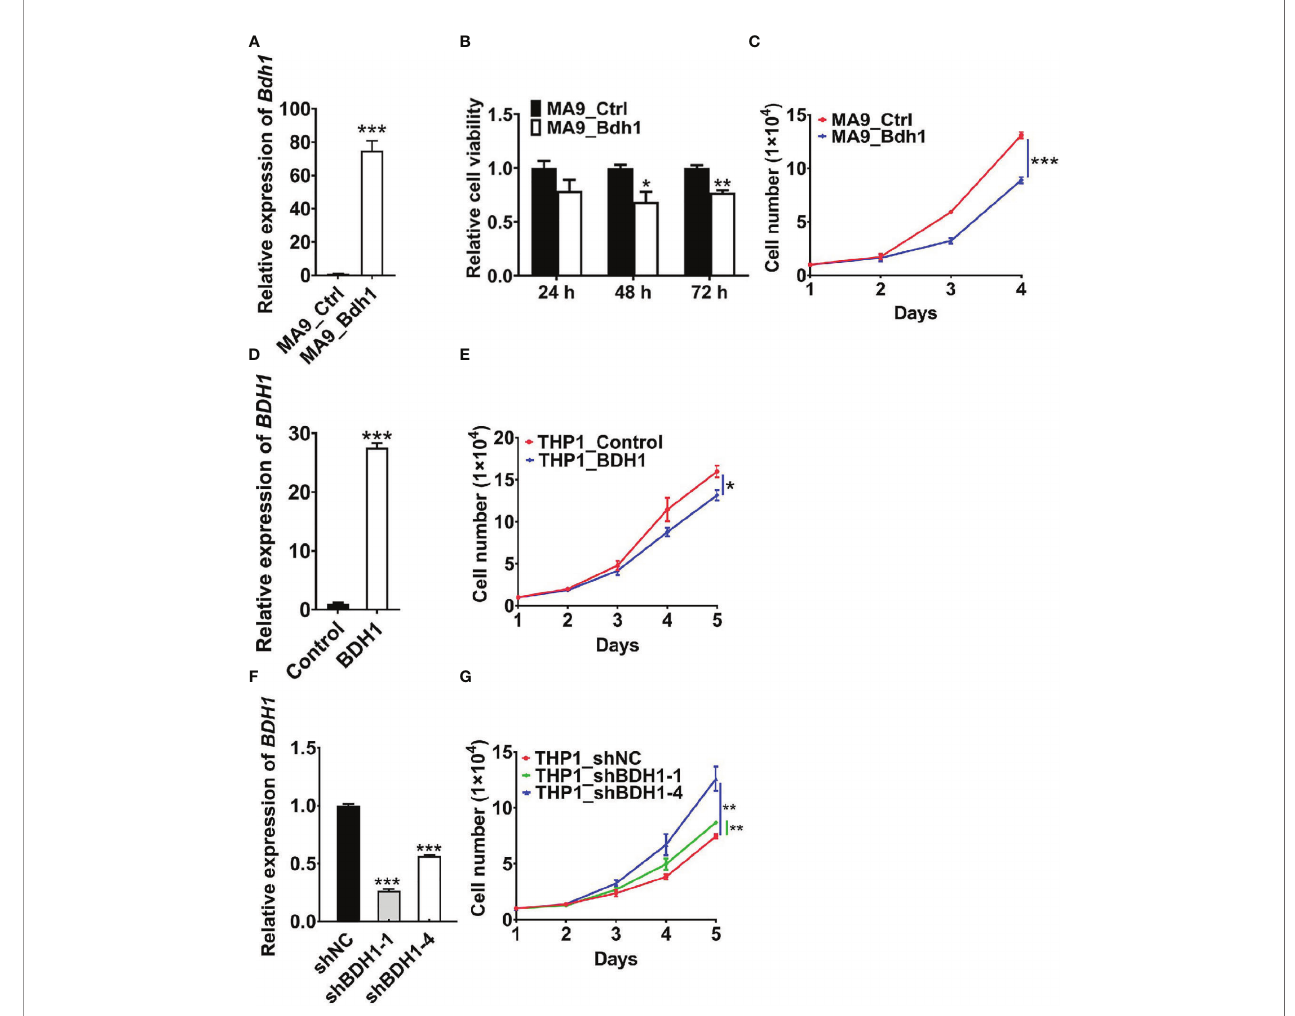
FIGURE 4 | BDH1 suppresses the growth of MLL-AF9 AML cells. (A) The expression level of Bdh1 in mouse BM cells infected with MSCVneo-MLL-AF9 (MA9), MSCV-PIG- Bdh1 (Bdh1) or MSCV-PIG (Ctrl) retrovirus was veri fi ed through qRT-PCR after positive screening for 5 days. (B) Bdh1 overexpression repressed cell viability of MLL-AF9 -transduced mouse BM cells. Mouse BM cells were infected with MSCVneo-MLL-AF9 (MA9), MSCV-PIG- Bdh1 (Bdh1) or MSCV-PIG (Ctrl) retrovirus. MTT assays were conducted 24, 48, 72 hours after seeding. (C) Cell number of each of the above groups was counted once per day until 4 days post- seeding. (D) The gene expression level of BDH1 in THP1 cells infected with PLJM1-GFP (Control), PLJM1-BDH1 (BDH1) lentivirus was veri fi ed through qRT-PCR after drug screening for 7 days. (E) BDH1 overexpression inhibited cell growth of THP1 cells. Cell number of each of the above groups was counted once per day until 5 days post-seeding. (F) The expression level of BDH1 in THP1 cells infected with PLKO.1-TRC (shNC), PLKO.1-BDH1-shRNA-1 (shBDH1-1) and PLKO.1- BDH1-shRNA-4 (shBDH1-4) lentivirus was determined by qRT-PCR after positive screening for 7 days. (G) BDH1 knock-down promoted the growth of THP1 cells. Cell number of each of the above groups was counted once per day until 5 days post-seeding. * p < 0.05, ** p < 0.01, *** p <